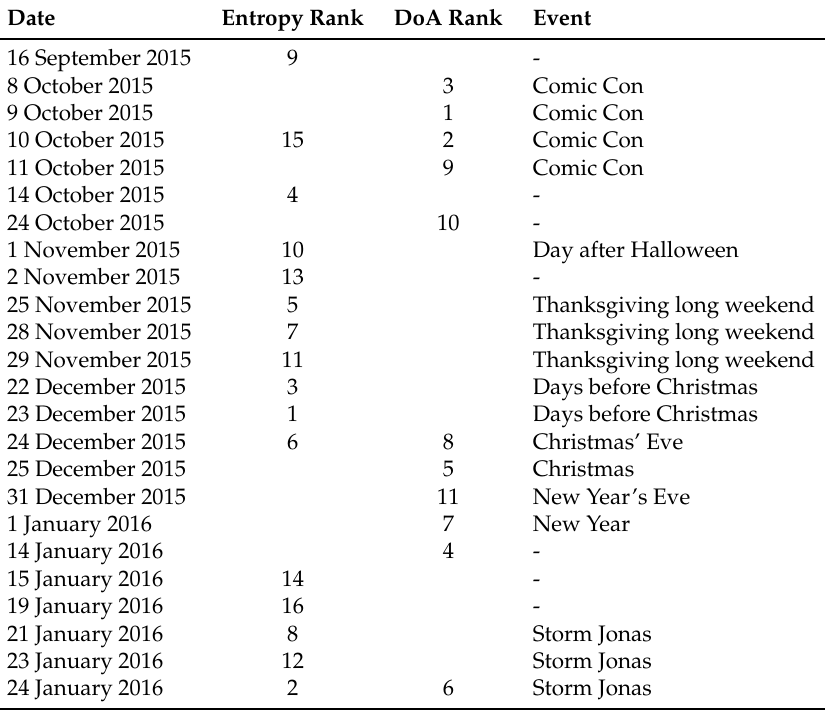
Table 2. Abnormal days detected using entropy and